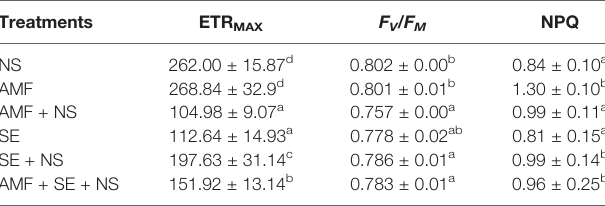
TABLE 2 | Maximum electron transporter rate (ETR MAX ), photochemical quantum yield of PSII ( F V / F M ), and nonphotochemical quenching (NPQ) measured in tomato plants treated with plant biostimulants.